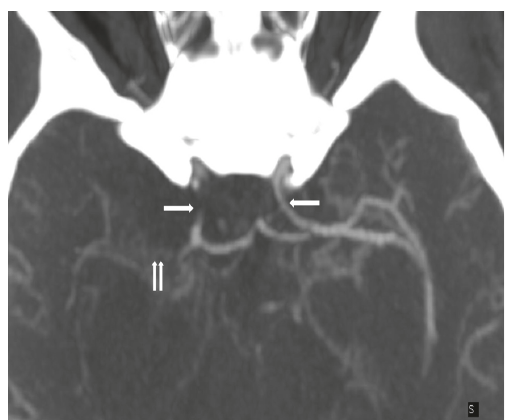
Figure 3: Maximum intensity projection (MIP) axial image of the CT angiogram demonstrates severe stenosis of the internal carotid arteries (single arrows) and occlusion of the Rt, MCA (double arrows).